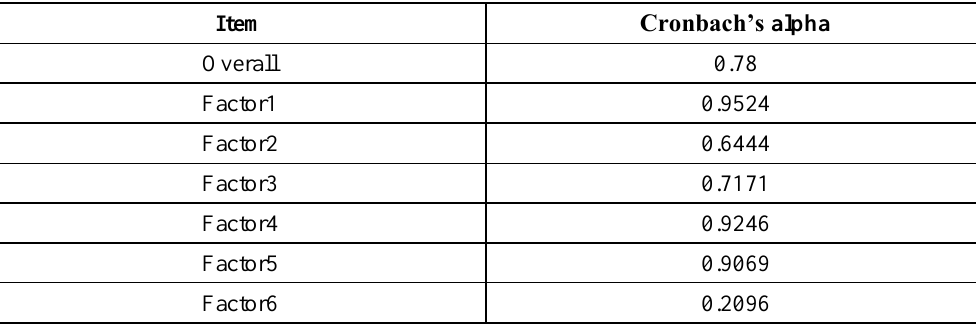
Table 6. Reliability Test of Cronbach’s